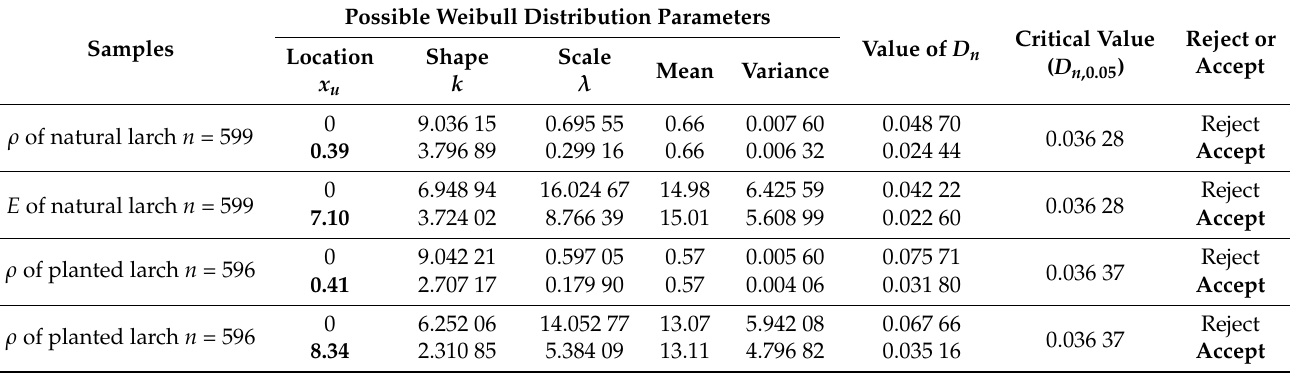
Table 5. K-S tests of the Weibull distribution with two and three parameters.